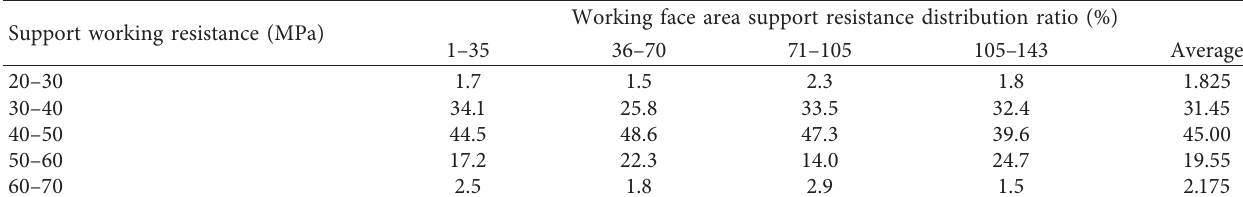
Table 2: Support resistance distribution in each area of the working